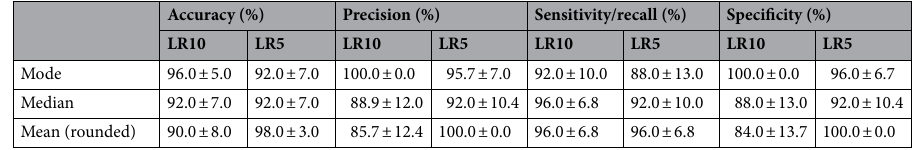
Table 1. Performance of the machine learning classifiers on aggregated crowd features when using the majority rules (mode), median, and mean aggregation methods. Performance metrics from the LR10 and LR5 classifiers are shown respectively. A probability threshold of 0.5 was used to distinguish the ASD and neurotypical classes.